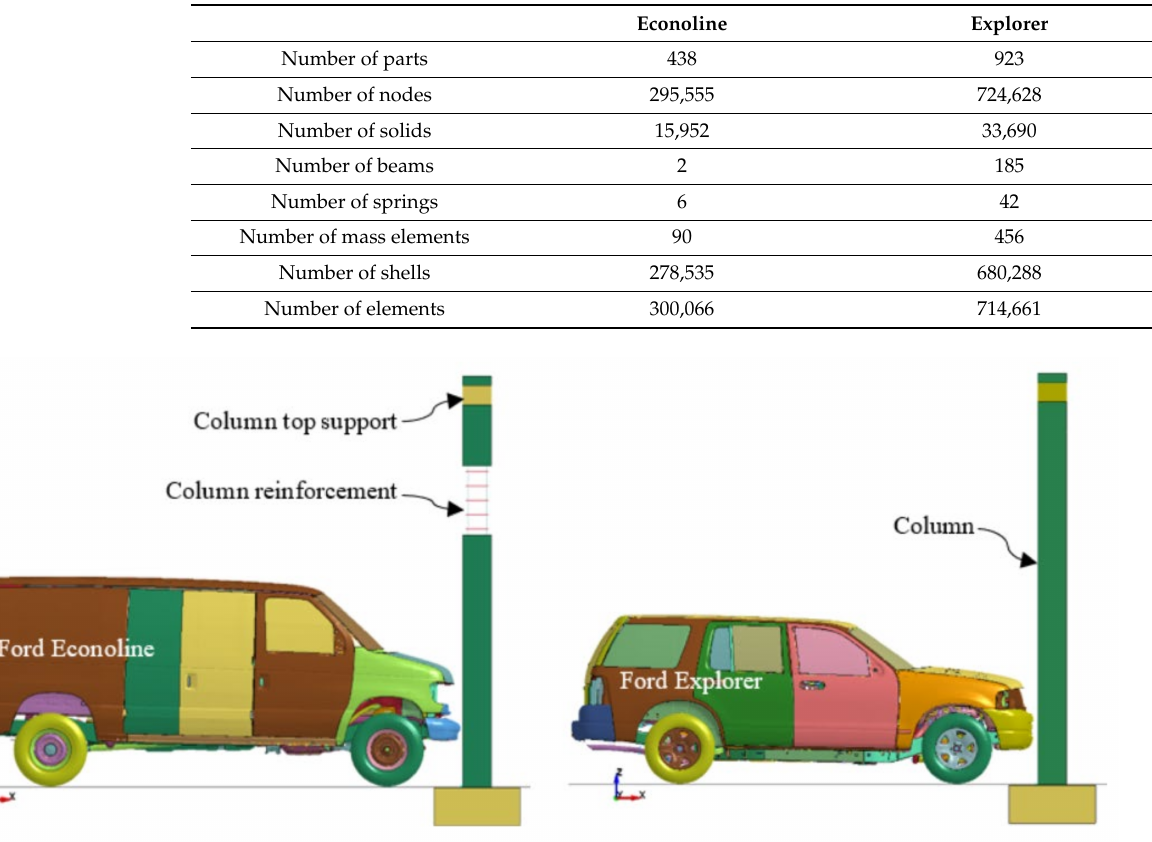
Table 2. Main features of the vehicle model.